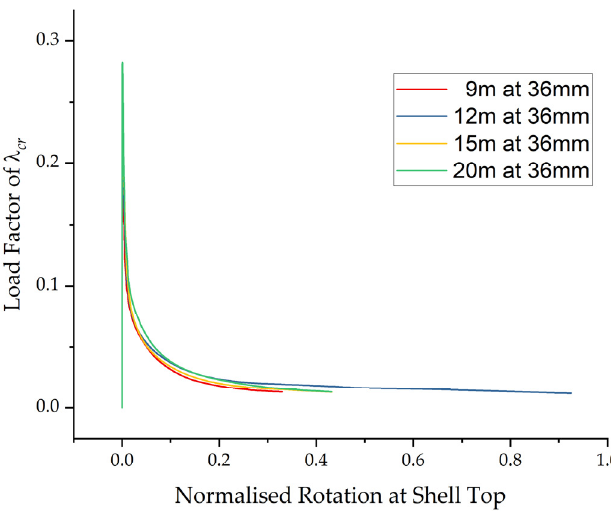
Figure 27. Load–rotation curves of 4 shell models of 36 mm thickness in different lengths.